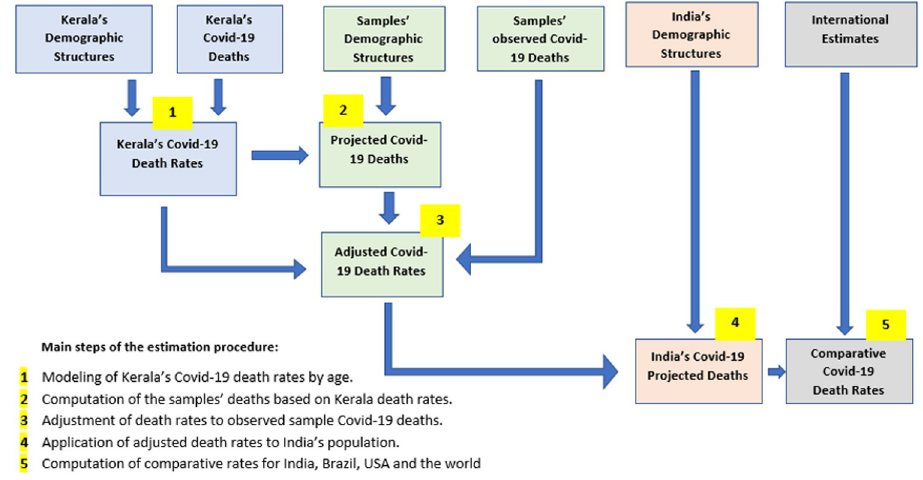
Fig 2. Procedure for estimating India’s Covid-19 deaths.